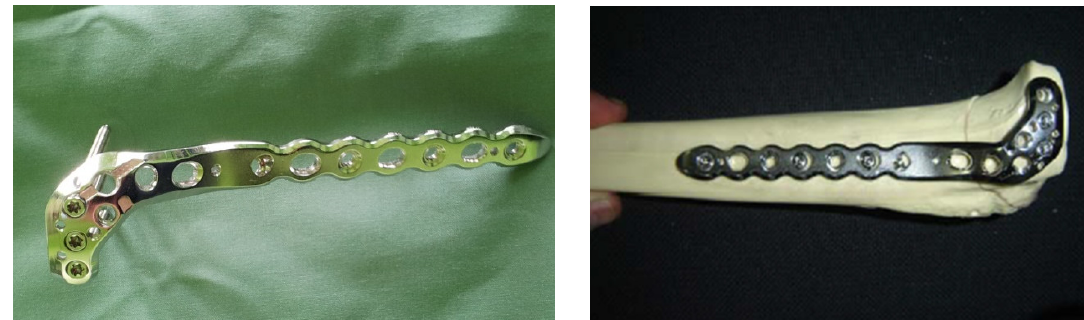
Figure 5. Locking Plate internal implant system.